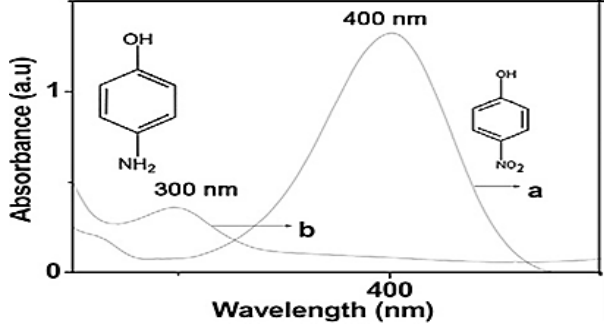
Fig. 7. UV–Visible spectrum of the (a) mixture of 4-nitrophenol and NaBH4, (b) mixture of 4-nitrophenol and NaBH4, 7 min after the addition of gold colloid